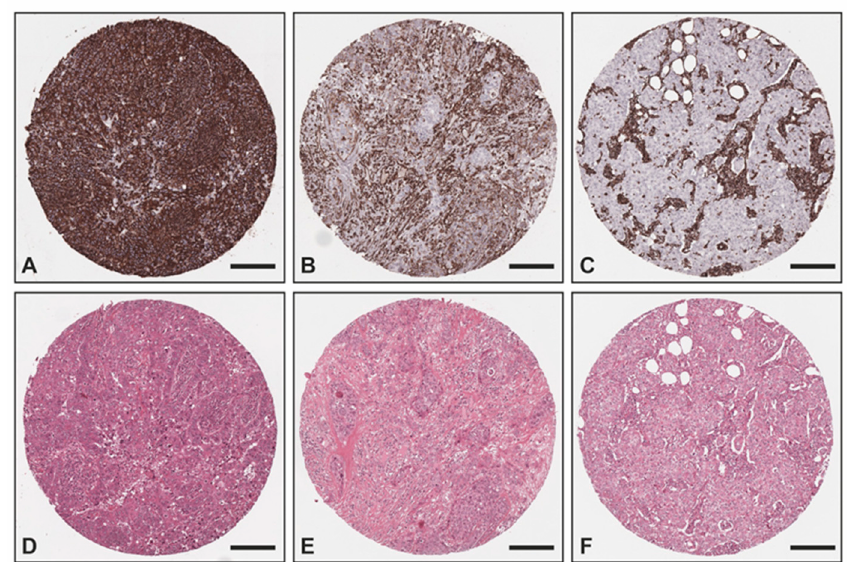
Figure 3. Exemplary images of vimentin IHC and corresponding H&E: ( A , D ) TNBC with strong positivity within the tumor cells as well as the tumor stroma; ( B , E ) TNBC with intermediate positivity within the tumor cells and strong positivity within the tumor stroma; ( C , F ) non-TNBC with no vimentin staining within the tumor cells and strong positivity within the tumor stroma. Scale bar—200 μ m.